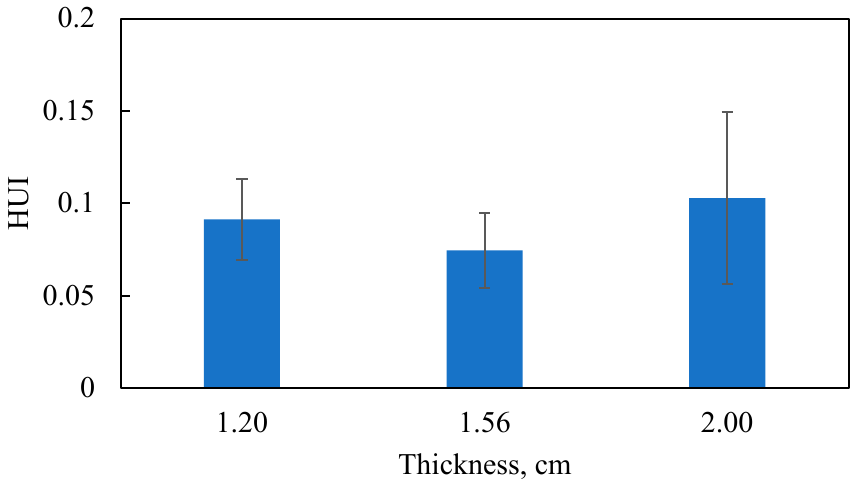
Figure 12. Experimental results of heating uniformity index expressed as mean ± standard deviation from duplicate.